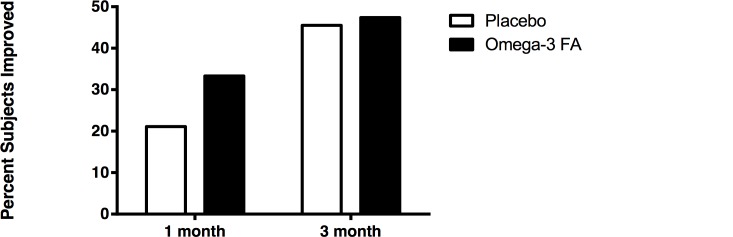
MADRS Improvement.This figure reflects percent of subjects improved by 50% or more from baseline MADRS score. Mixed effects logistic regression model adjusted for age and MS disease duration. No difference between placebo and omega-3 FA was found over 3 months (p = 0.30).